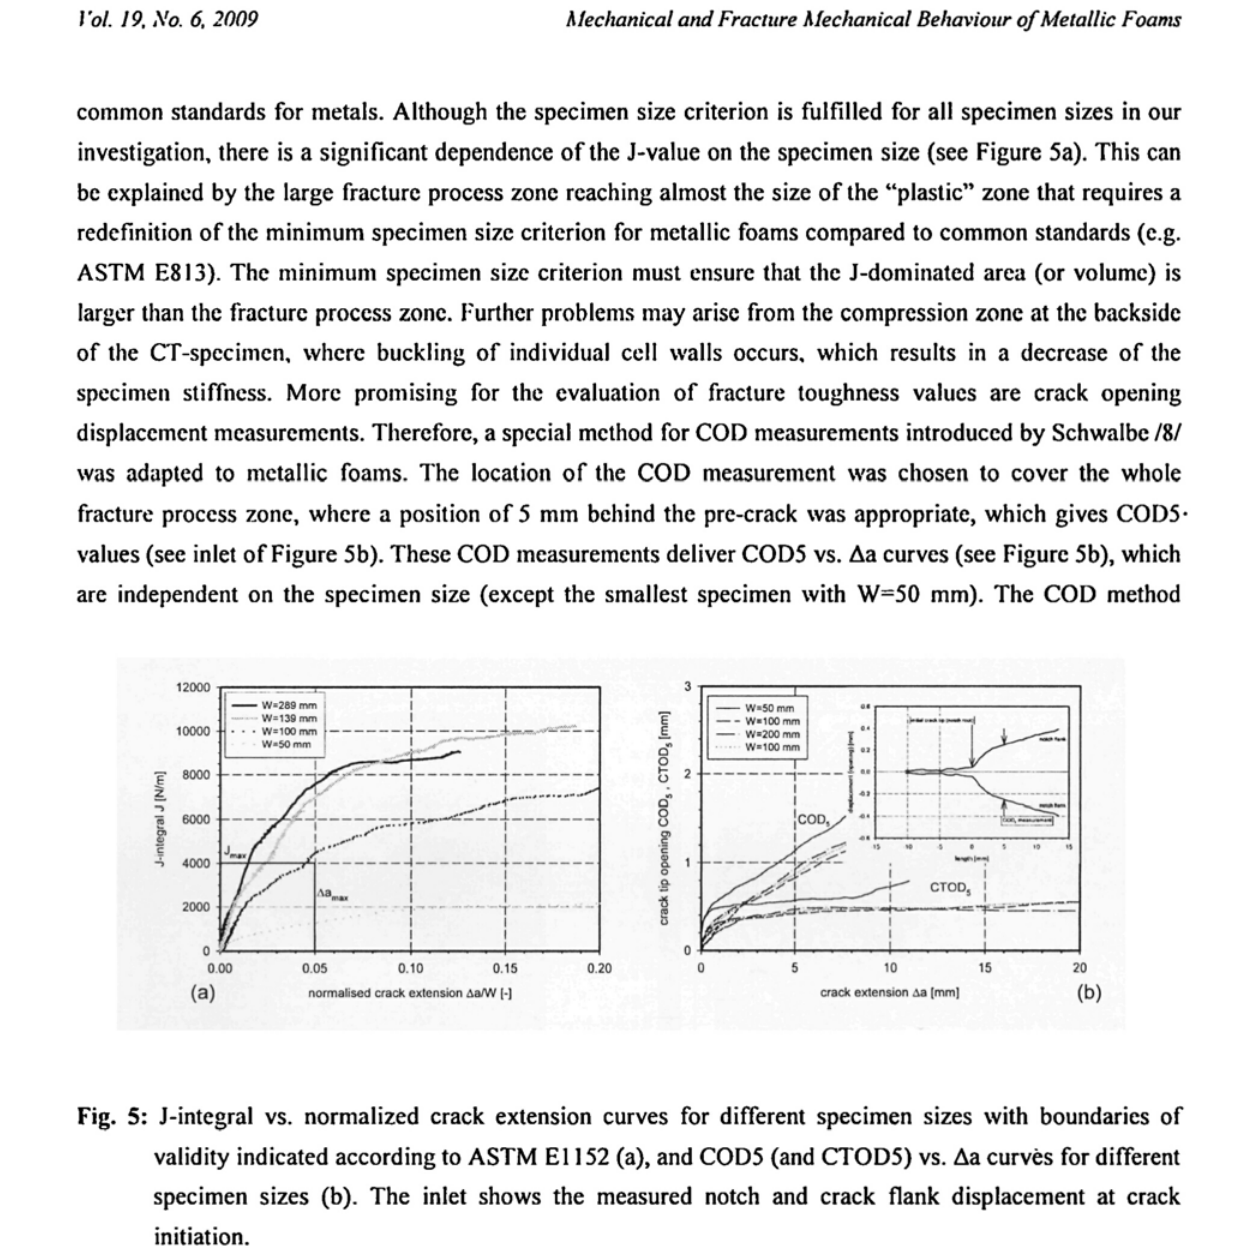
Fig. 5: J-integral vs. normalized crack extension curves for different specimen sizes with boundaries of validity indicated according to ASTM El 152 (a), and COD5 (and CTOD5) vs. Aa curves for different specimen sizes (b). The inlet shows the measured notch and crack flank displacement at crack